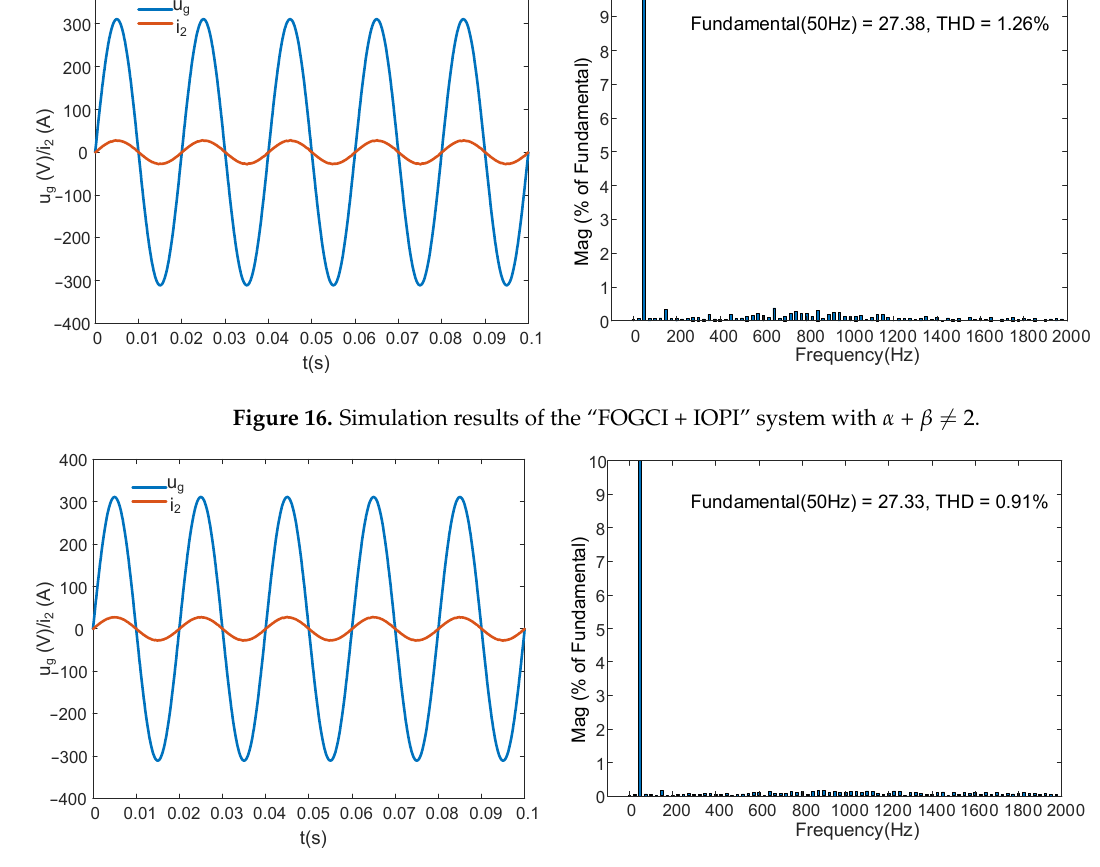
Figure 17. Simulation results of the “FOGCI + FOPI” system with α + β ≠ 2. For the FOGCI, α + β = 2 (α = 1.2, β = 0.8), and the IOPI controller was used to regulate the grid current at the beginning. The capacitor current feedback coefficient H i 1 = 0.1. When t = 0.05 s, H i 1 was set to 0, and the system became unstable, as shown in Figure 18.